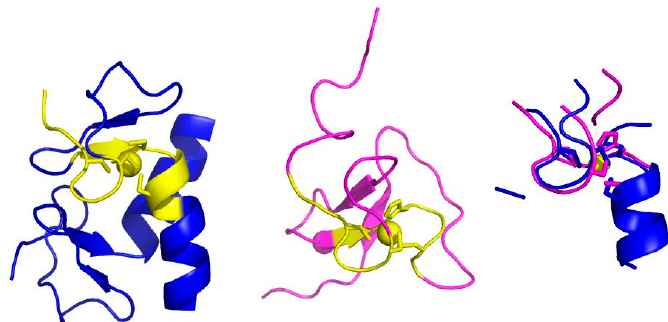
Figure 5. Overlap of two zinc MFSs embedded in two different folds. The full PDB structures clearly reveal different folds for the two proteins (PDB structures 1OVX, blue, and 1FP0, magenta), but the superposition of the two sites in the rightmost panel is very good (MetalS 2 score = 2.29). The yellow regions in the two full structures correspond to the segments matched in the MFS superposition. The zinc ions are shown as yellow spheres; the zinc-binding residues are shown as sticks.